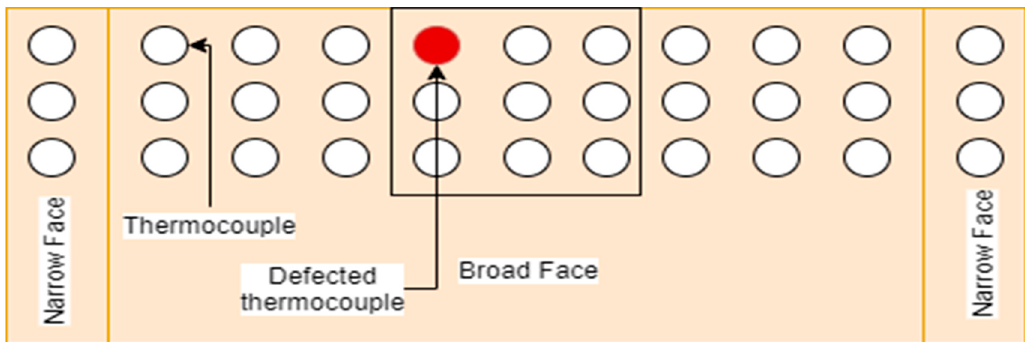
Figure 6. Mold replacement is not mandatory.